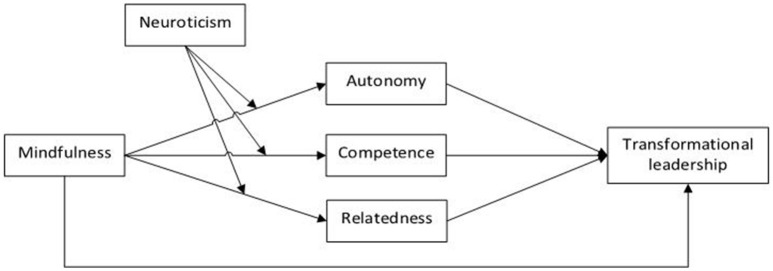
Theoretical model.